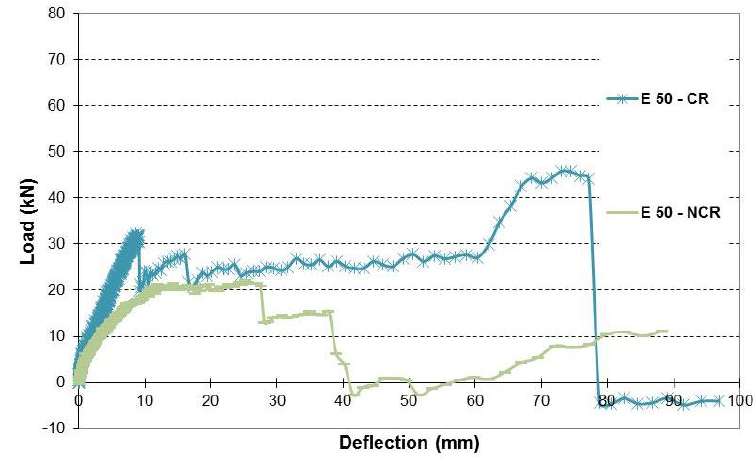
Figure 27. Load-deflection relationship of repaired beams with 50% corrosion level with and without cover. Table 9. Failure description of beams without cover and repaired with double sheets.